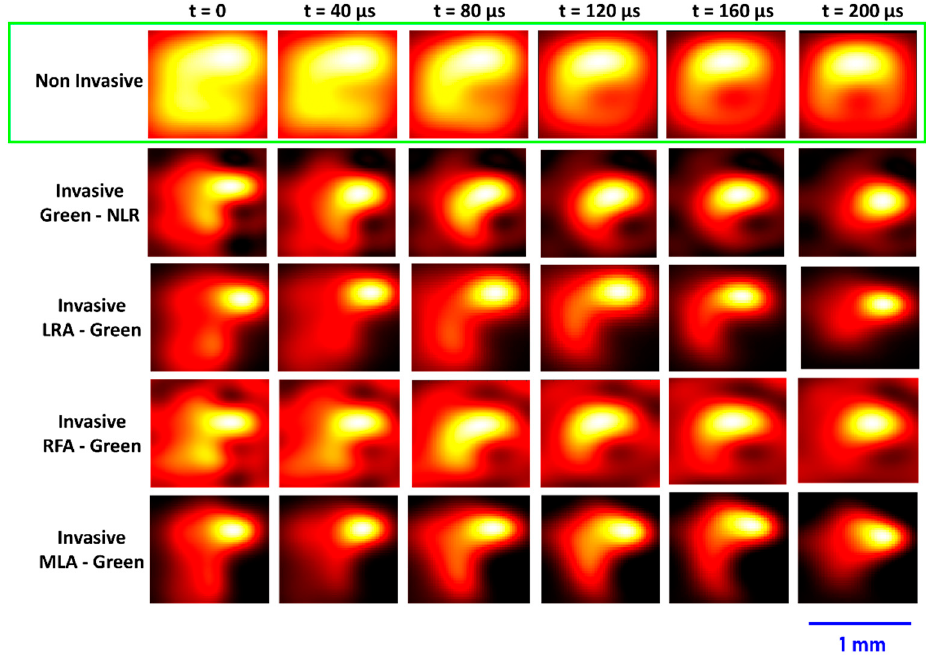
Figure 7. Reconstructed intensity distributions for the spark event separated by t = 40 µ s non-invasive and invasive methods NLR, LRA, RFA and MLA for green PSF.